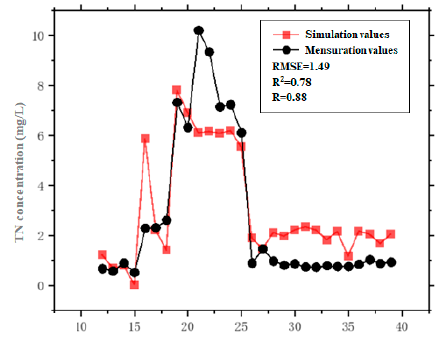
Figure 11. Simulated statistical results of total nitrogen (TN).